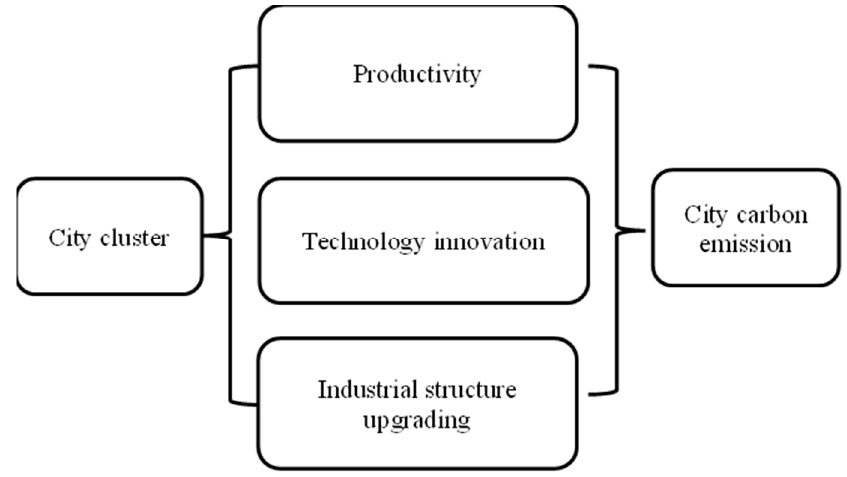
Figure 1. Theoretical hypothesis framework.